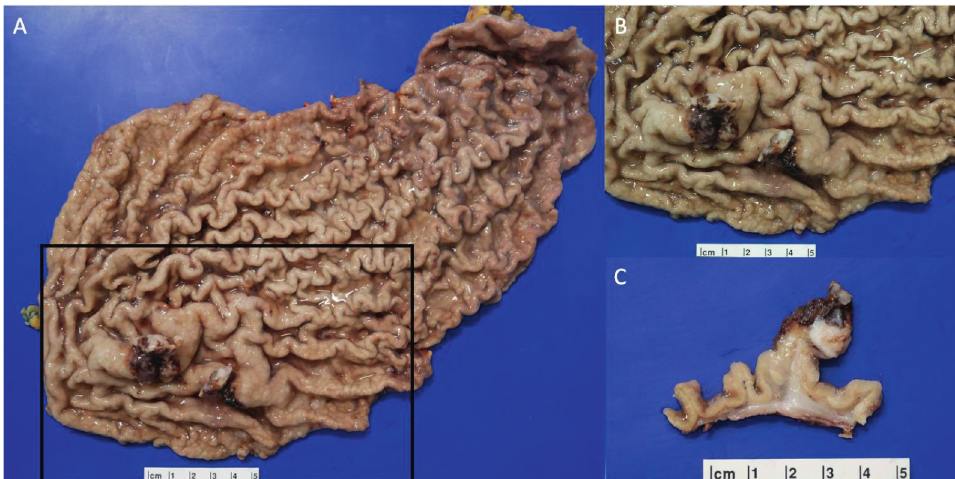
Figure 2: Gross lesion. (A) Image shows a fungating mass 3cm from the margin. (B) Close-up of gross ulcerating and fungating lesion. Also seen is the diffuse granular appearance of the mucosa, which represents fundic gland polyps occurring diffusely throughout the stomach. (C) Internal view of the mass shows that the lesion was ulcerated, fungating, and growing separately from the gastric